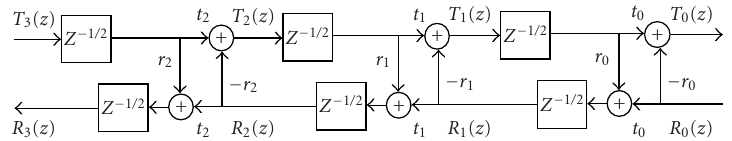
Figure 2: Signal flow diagram for three stages of an optical lattice filter.